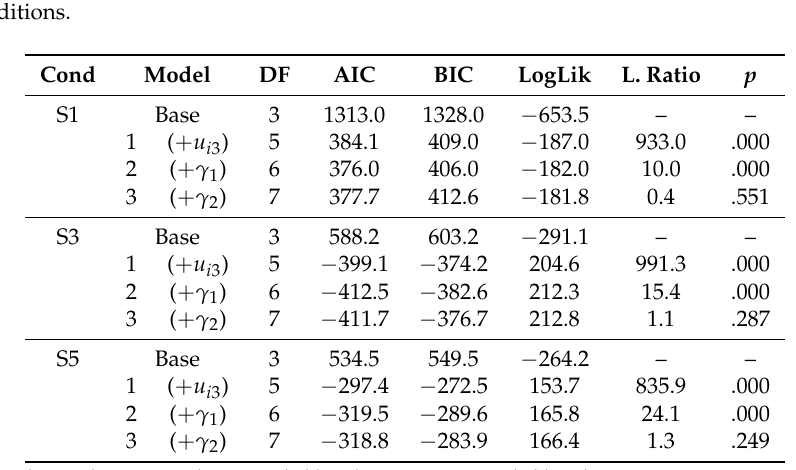
Table 6. Estimates for model fit of the MLM with standardized regression weights across all three